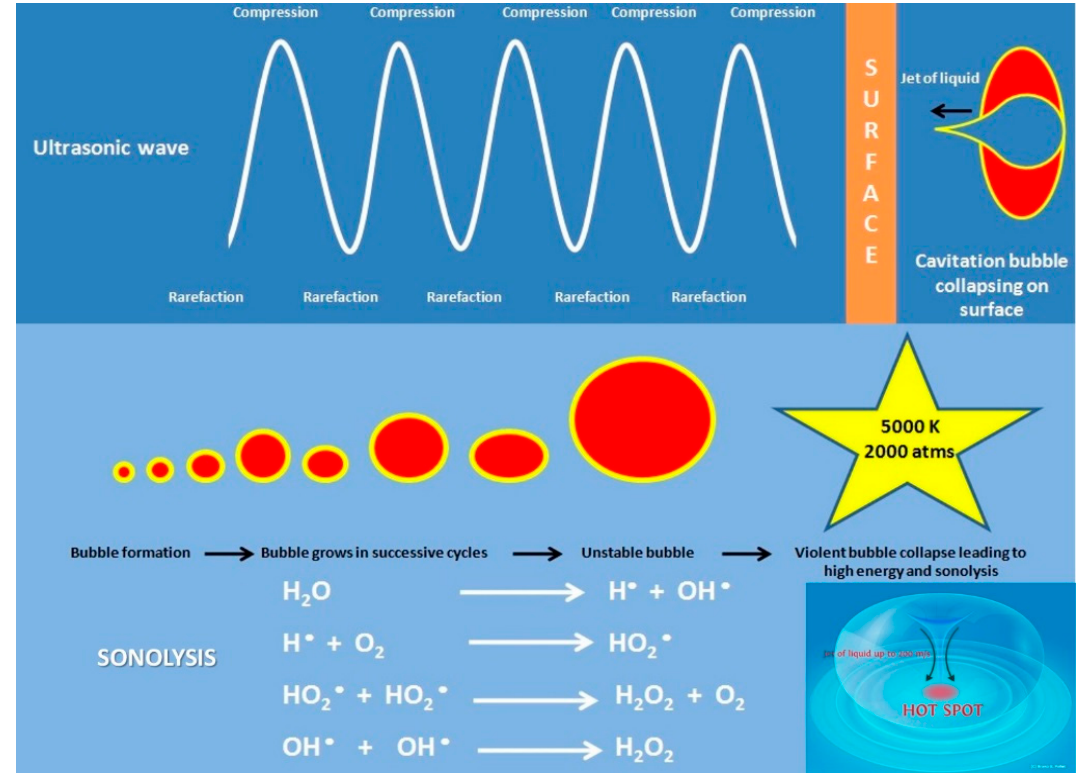
Figure 2. Ultrasonic effects in a liquid and near a solid surface [15].